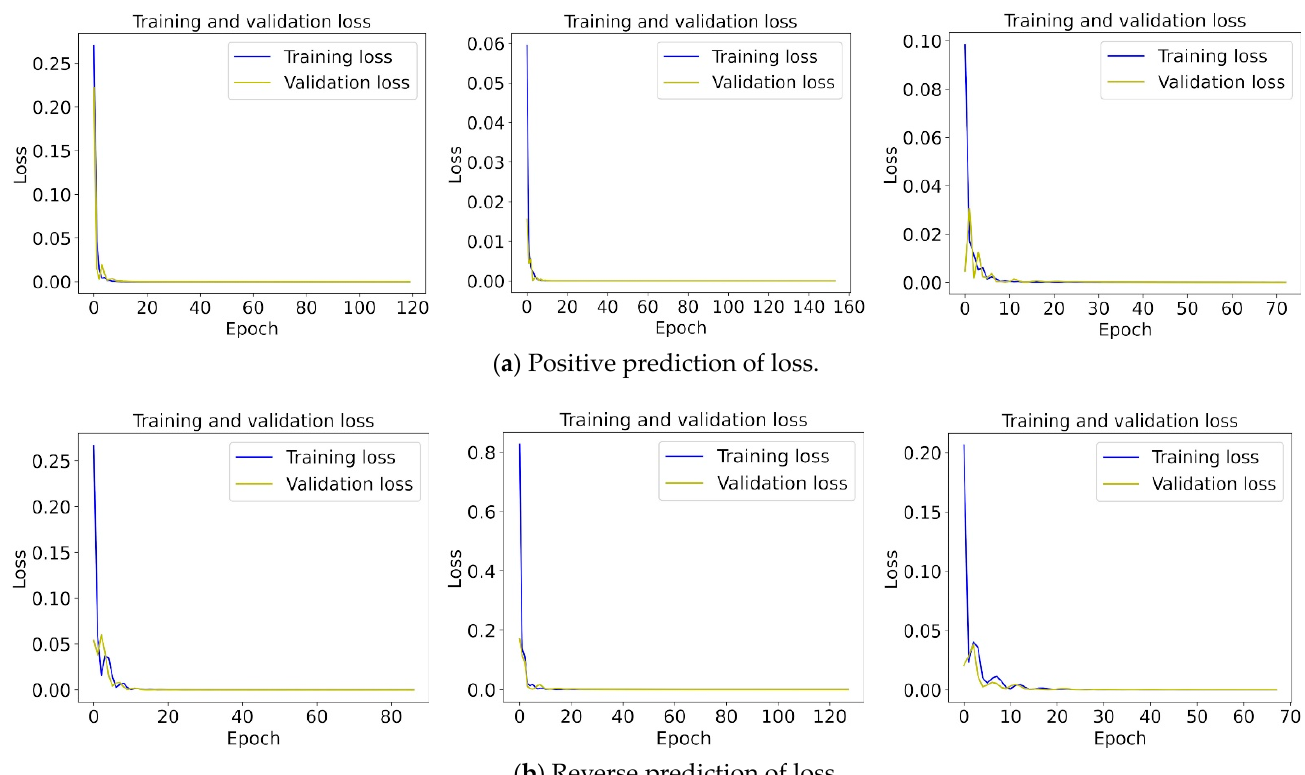
Figure 10. Loss variation curve with the number of iterations. ( a ) represents forward training and ( b ) represents reverse training. The blue line is the training set and the yellow line is the validation set.